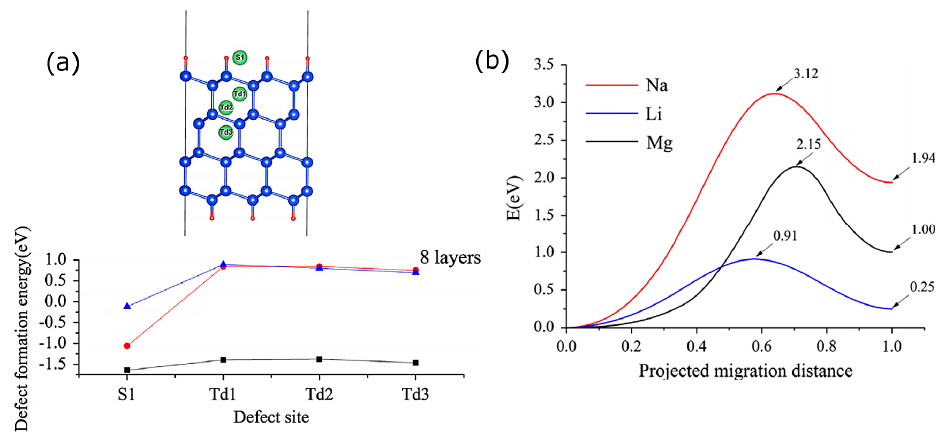
Figure 2. ( a ) Defect formation energies of Li (black), Na (red), and Mg (blue) at surface and insertion sites of a Si nanosheet (vs. single atom reference); ( b ) Diffusion barriers from the surface to the subsurface sites. Reprinted with permission from Ref. [11], © (2013) Elsevier.